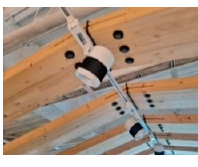
Figure 11. Fixed object with a small indoor space.